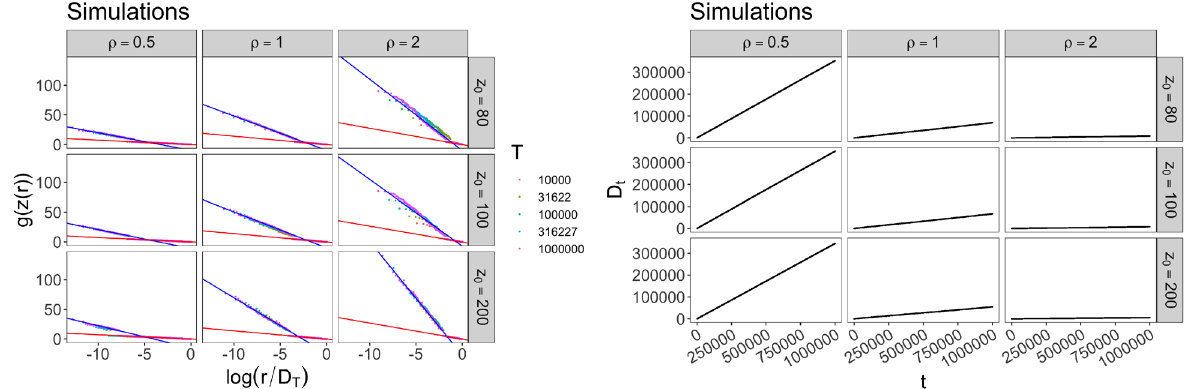
2 , ν 0.75 and different values of ρ and z z 0 : (Left) = = ∗ = and log-log after R . The different colors ∗ ∗